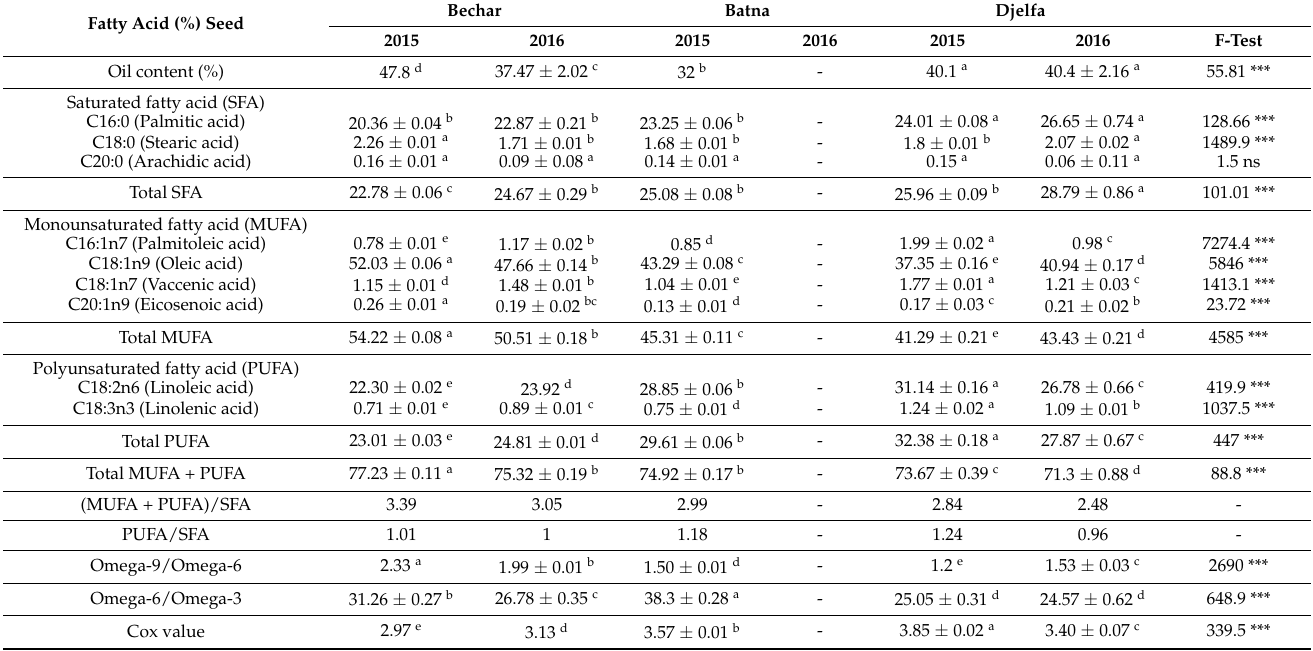
Table 2. Fatty Acids (%) Composition and Oil Content (%) of Seeds of Atlas Pistachio in Three Geographic Zones in Algeria for Two Years (2015 and 2016).